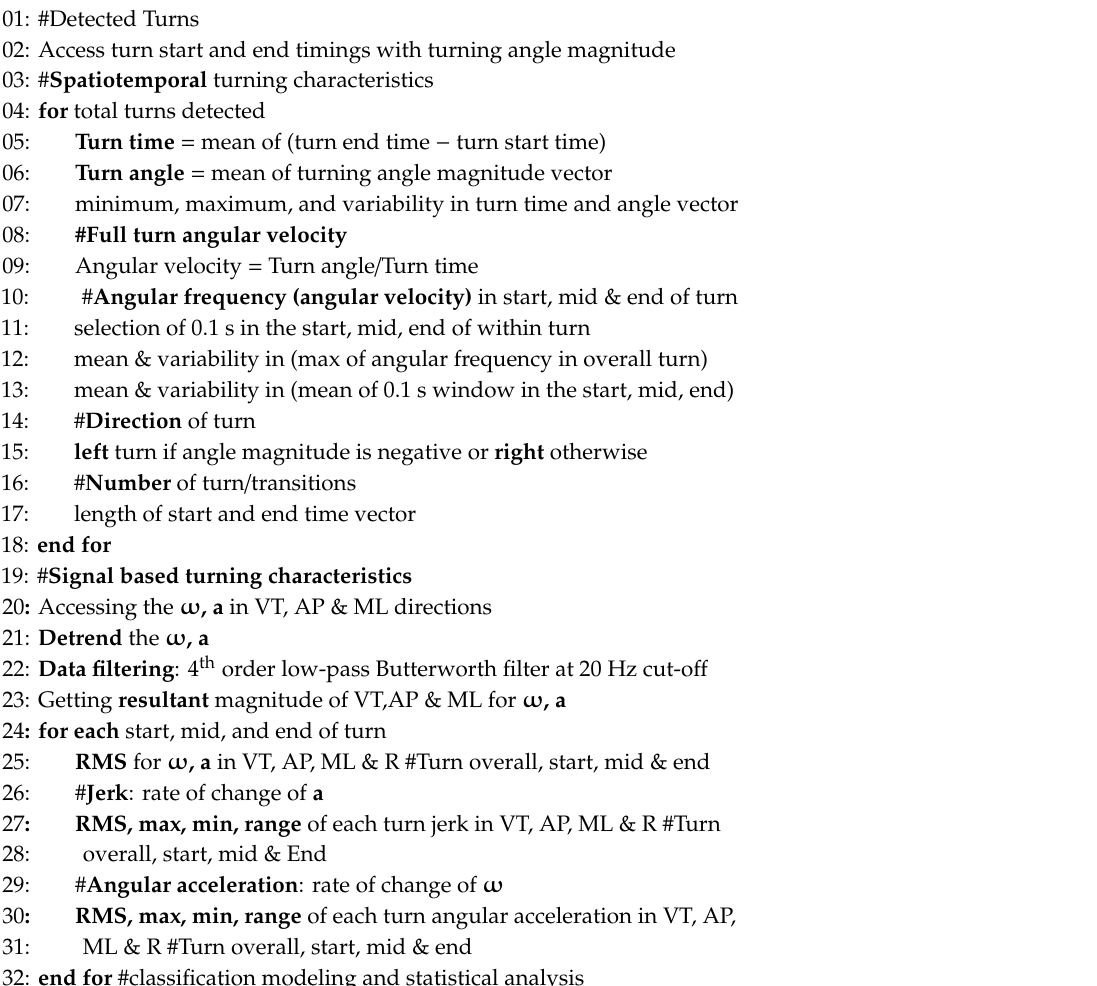
Algorithm 2. Pseudo code for turning features